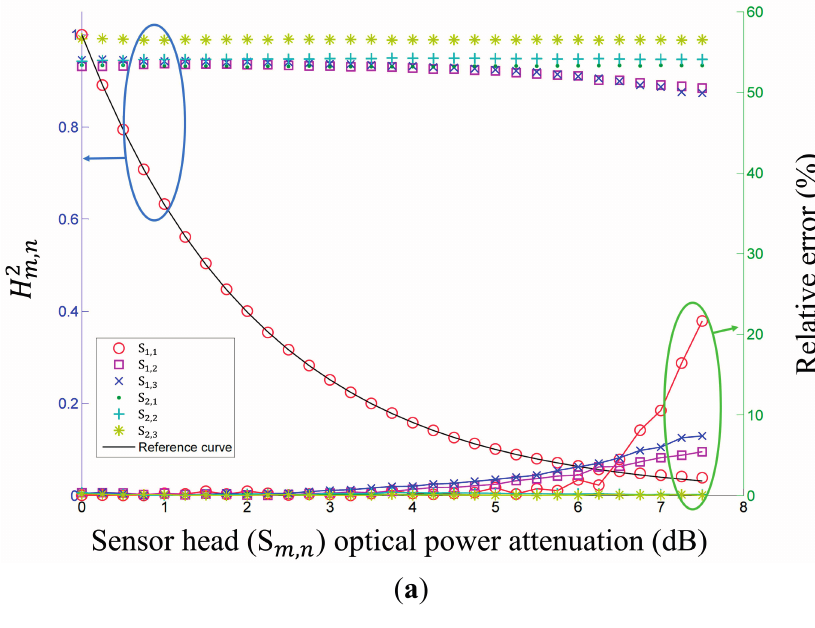
, S , (cid:2869),(cid:2869) (cid:2869),(cid:2870) with optical power variation and other (cid:2869),(cid:2869) with optical power variation and (cid:2869),(cid:2870) with optical power variation (cid:2869),(cid:2871)